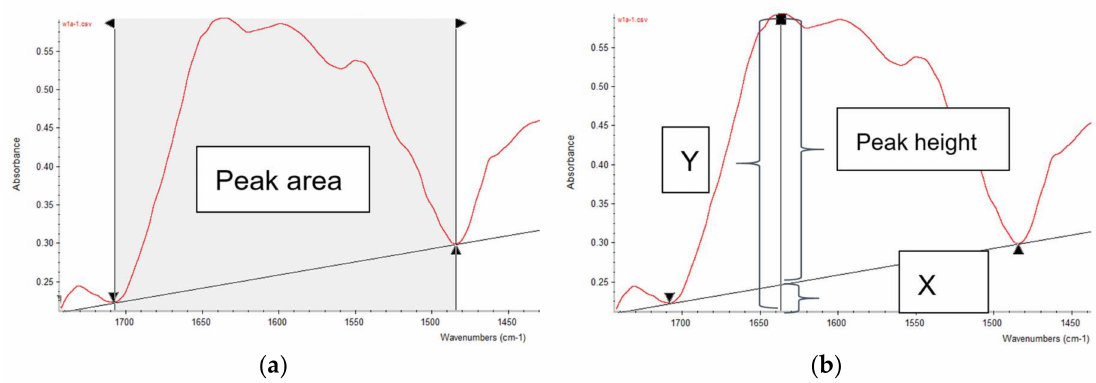
Figure 6. Illustrations of peak area and peak height measurements. ( a ) Peak area measurement. Corrected peak area equals the total area below the red spectrum minus the area below the baseline (straight black line); ( b ) Peak height measurement. Corrected peak height equals the total height (Y) minus the height below the baseline